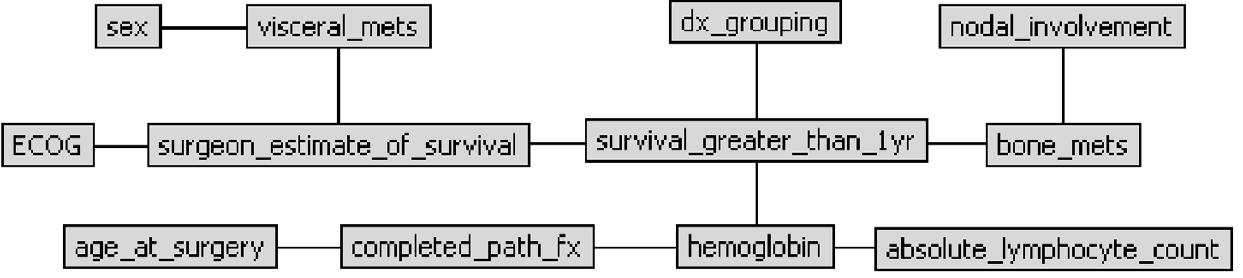
Figure 3. Twelve-month BBN model. As shown, there are four first-degree predictors of 12-month survival: the surgeon’s estimate of survival (‘‘surgeon_estimate_of_survival’’), preoperative hemoglobin concentration (‘‘hemoglobin’’), the number of bone metastases (‘‘bone_mets’’), and the primary oncologic diagnosis (‘‘dx_grouping’’). In contrast to the 3-month model, the network structure of the 12-month model indicates that the ECOG performance status (‘‘ECOG’’) and the presence of visceral metastases (visceral_mets) are both first-degree associates of the surgeon’s estimate node.